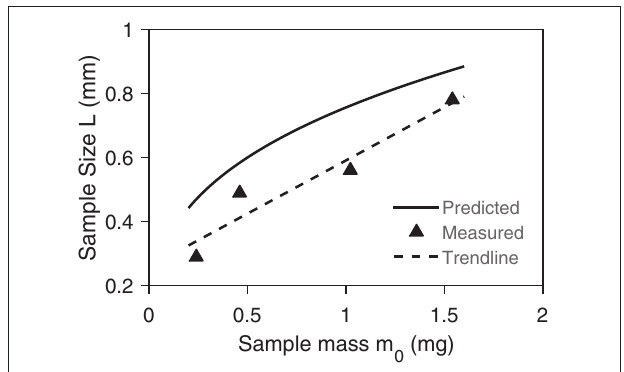
FIGURE 9 | Comparison between predicted and measured length scale of sample in TGA. The measurements are from Paulsen et al.